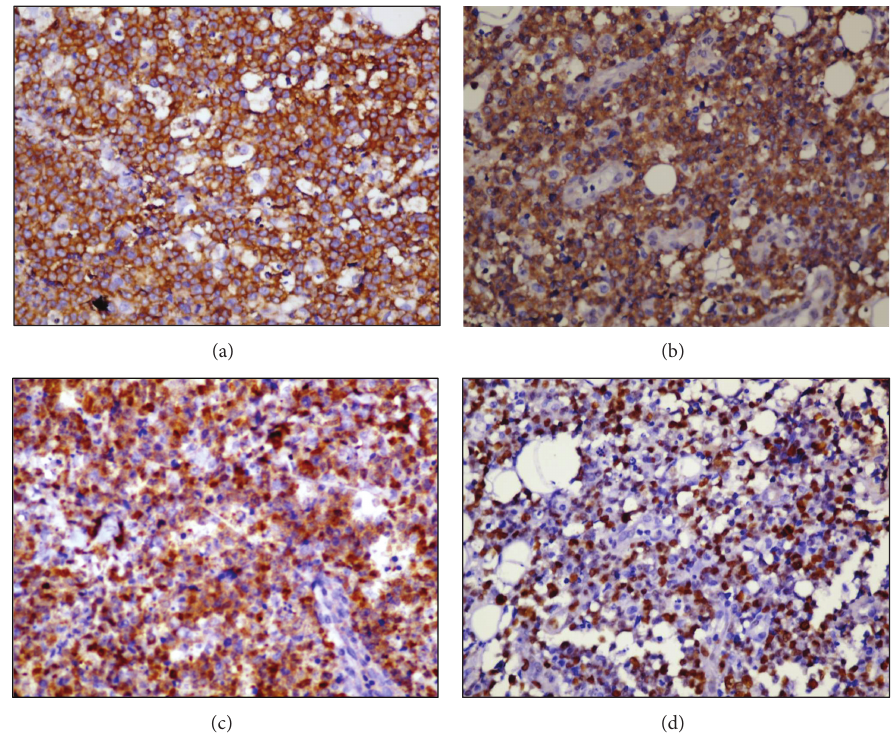
Figure 4: On immunohistochemistry the tumor cells showed uniform intense positivity for leukocyte common antigen (LCA) (a), CD3 (b), and CD30 (c), with a high proliferation index (Ki-67 = 70%) (d). Note the uniform, strong Golgi region positivity of CD30 (c) in the majority ( > 75%) of tumor cells. The cells were negative for pancytokeratin, CD20, anaplastic large cell lymphoma kinase (ALK), and epithelial membrane antigen (EMA) (Peroxidase-antiperoxidase stain, a and b; 100x, c; 200x).